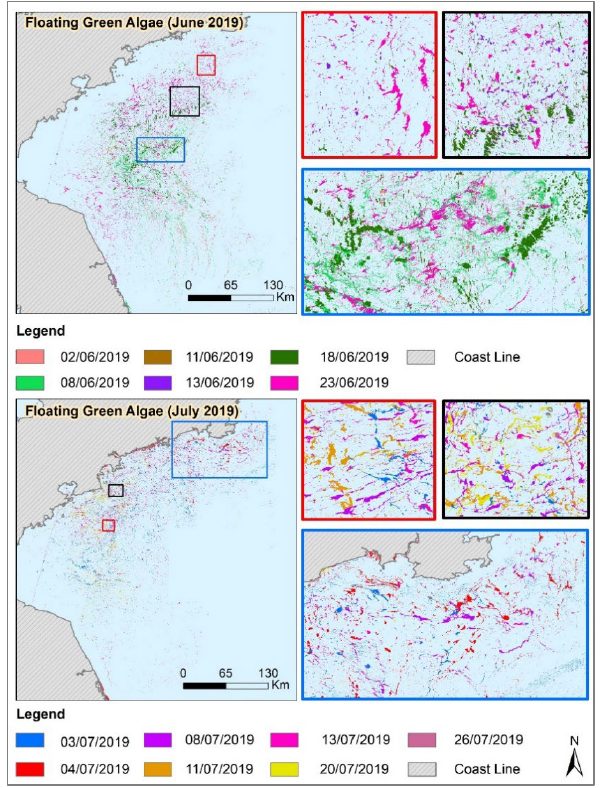
Figure 7. Coastal floating algae during June and July 2019 in the Yellow Sea.